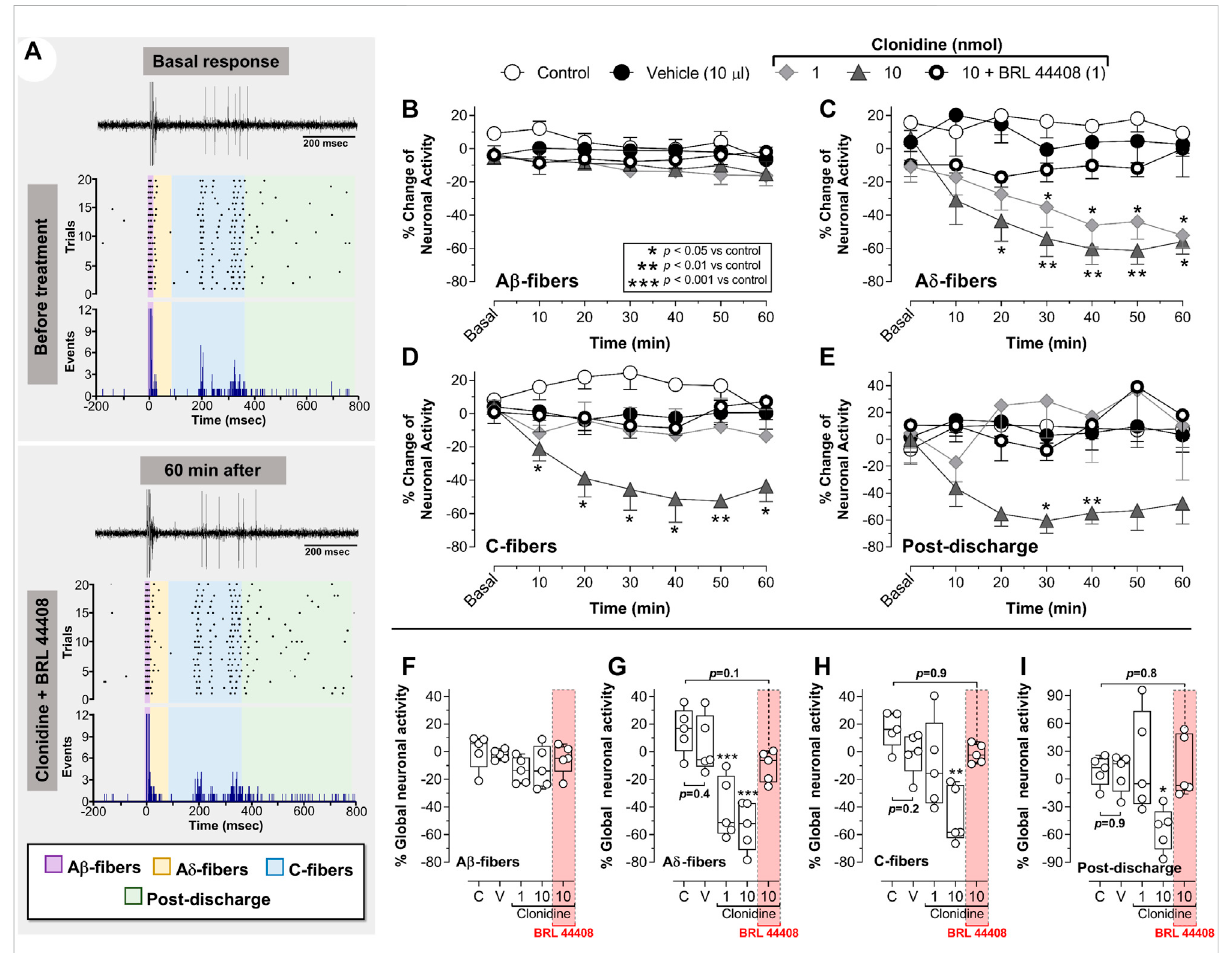
FIGURE 6 Theroleofspinal α 2A -adrenoceptorsinclonidine-inducedelectrophysiologicalantinociception.In (A) ,apairofrawtracingsofasinglesecond- order WDR neuron cluster response induced by one electrical stimulus (upper tracing), the raster plot (middle), and peri-stimulus time histogram (PSTH)depictingtheeffectofBRL44408ontheclonidine-inducedantinociception.Noticethatunder α 2A -adrenoceptorsblockadewithBRL44408 (1 nmol), the antinociceptive action of clonidine is not elicited. (B – E) show the time-course changes in the percentage average of the different fi bersactivating WDR cellresponses andpost-dischargeelicitedbyreceptive fi eld(RF)electrical stimulation andtheeffectsofspinal clonidine (1and 10 nmol/10 μ l; n = 5 each dose). Notice that 1 nmol clonidine only inhibits the neuronal fi ring of A δ - fi bers (C) , while 10 nmol clonidine inhibits the activity of A δ - fi bers (C), C- fi bers (D) , and post-discharge (E) . (F – I) show the global neuronal activity (obtained from the respective time